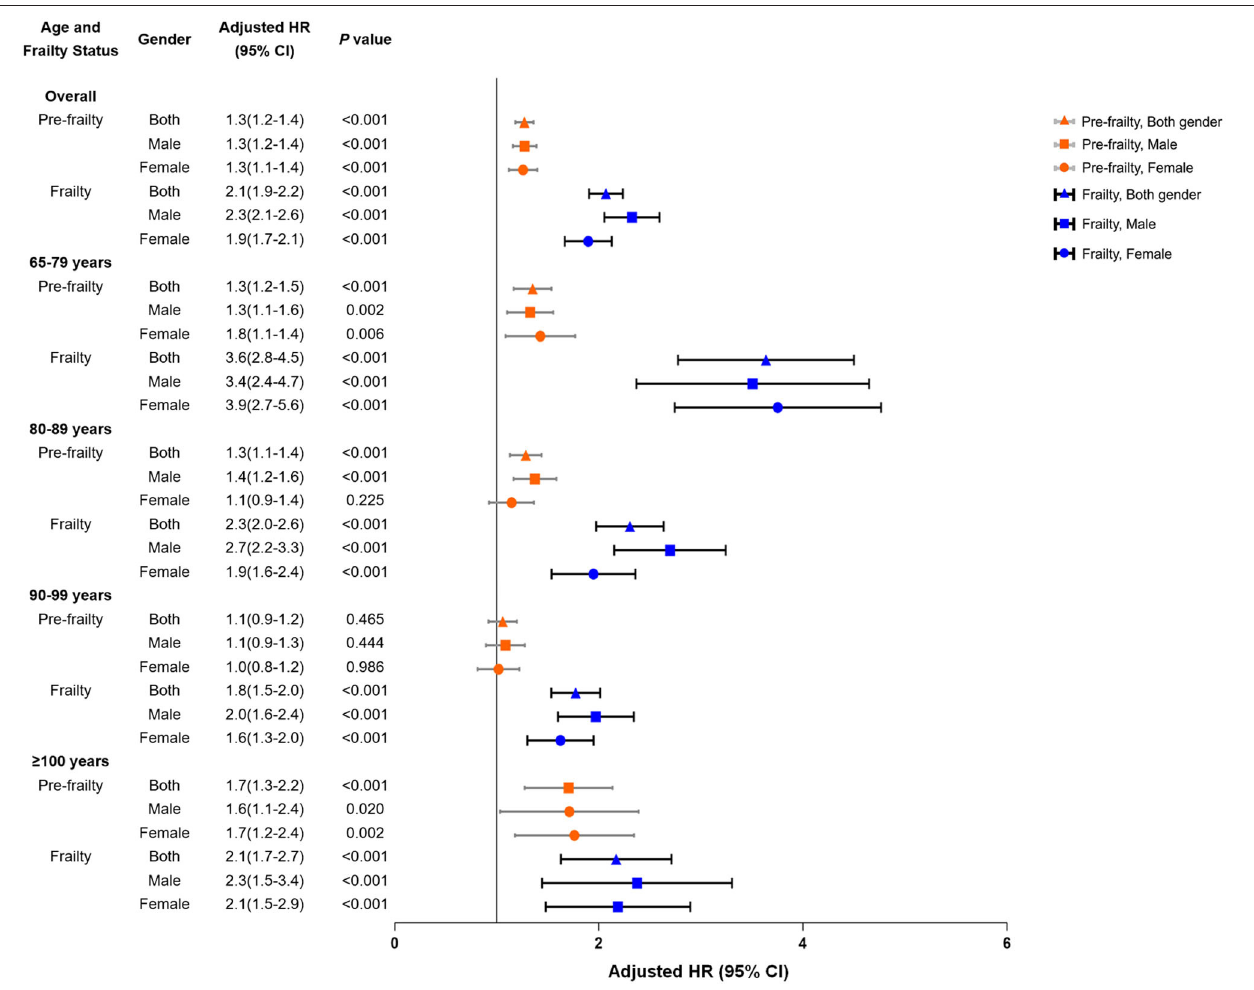
FIGURE 2 | All-cause mortality for pre-frailty and frailty at baseline, stratified by age and gender. Adjusted for education, household income, smoke status, and comorbidity count at baseline.